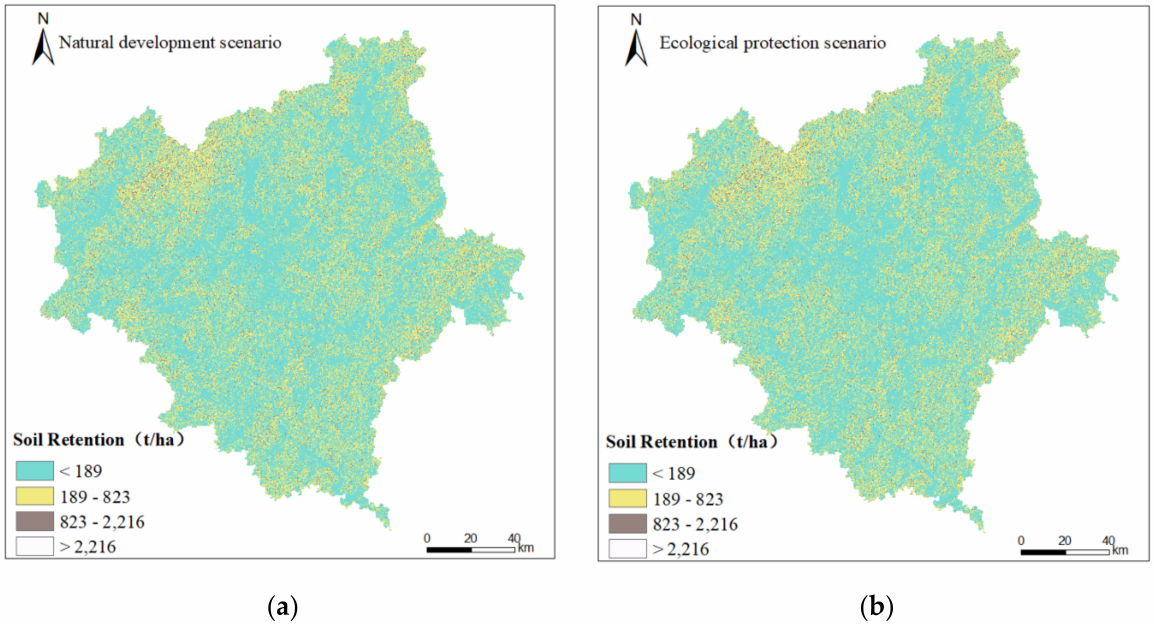
Figure 5. Spatial distribution of soil retention in 2025 under ( a ) the natural development scenario and ( b ) the ecological protection